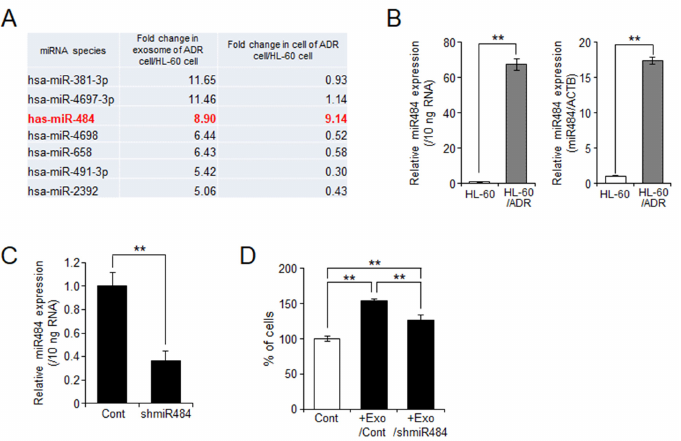
Figure 6. Exosomes purified from HL-60/ADR suppress doxorubicin-induced apoptosis in HL-60 cells. ( A ) Microarray experiments were performed to identify miRNAs in exosomes and cells. The seven candidate miRNAs showed more than a 5.0-fold increase among the total 2563 miRNAs spe- cies in HL-60/ADR cells compared with those in HL-60 cells. ( B ) Validation of miR-484 levels in exosomes (left) and cells (right) was performed by qPCR. ( C ) Knockdown of miR-484 by shRNA (shmiR-484) was performed by transfection of pLKO.1-shmiR-484 vector in HEK293 cells. Control cells were introduced with pLKO.1 control vector. The expression of miR-484 in exosomes was an- alyzed by qPCR. ( D ) HL-60 cells were treated with 3 × 10 9 exosomes from HEK293/control (Exo/Cont) or HEK293/shmiR-484 (Exo/shmiR-484) for 24 h. Viable cells were detected by trypan blue dye exclusion method. The values show the mean ± SD ( n = 3). ** p < 0.005.